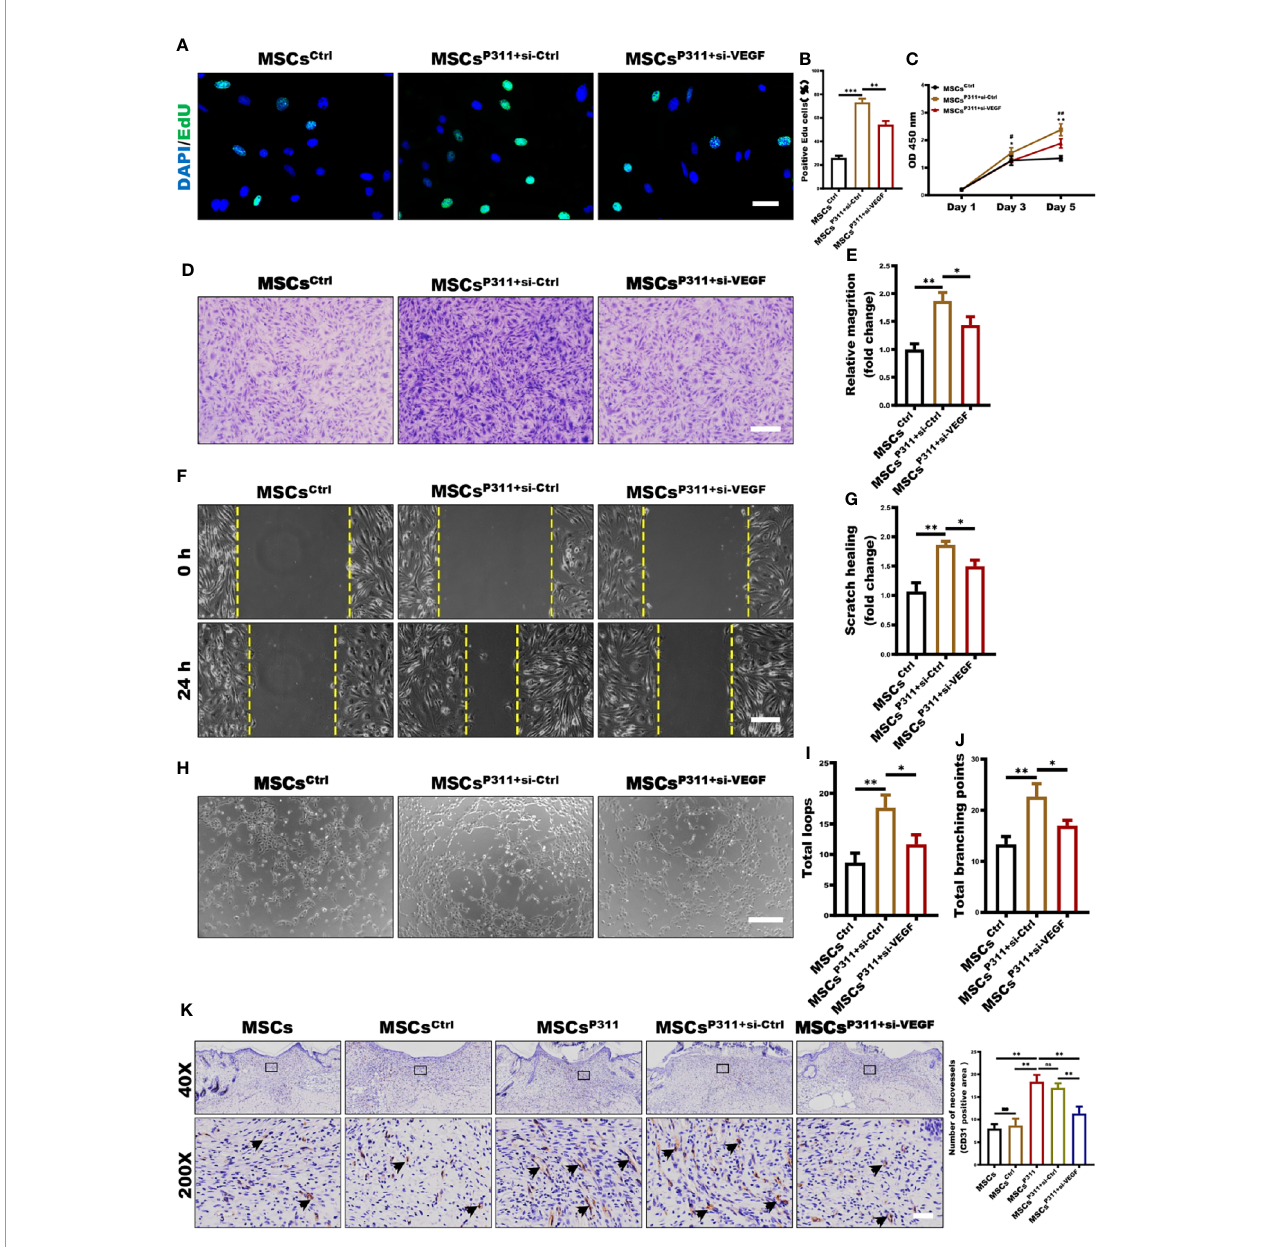
FIGURE 5 | VEGF is essential in P311-mediated angiogenesis of MSCs in vitro and in vivo . The roles of VEGF in P311-mediated promotion of MSCs on ECs proliferation and motility were estimated by using MSCs P311 transfected with VEGF si-RNA (MSCs P311+si-VEGF ) or control vehicle (MSCs P311+si-Ctrl ). (A – E) Using transwell system mentioned above, ECs were co-cultured with MSCs P311+si-VEGF or MSCs P311+si-Ctrl for 24 hours at ratio 4:1. (A, B) The proliferation of ECs was examined at single cell level by EdU assays at 24 hours after co-incubation. Representative confocal images of EdU were shown (left panel), and the number of EdU- positive cells was counted and statistically analysed (right panel). Scale bar: 100 µm. (C) Cell viability for ECs was detected by means of CCK8 assay on day 1, 3 and 5 after co-incubation. (* means MSCs Ctrl vs MSCs P311+si-Ctrl , # means MSCs P311+si-Ctrl vs MSCs P311+si-VEGF ) (D – G) The roles of VEGF in P311-mediated increase in motility of ECs was estimated by detecting the invasion and migration in MSCs P311+si-VEGF or MSCs P311+si-Ctrl co-incubation. (D, E) ECs in upper chamber were co-cultured with MSCs Ctrl , MSCs P311+si-VEGF or MSCs P311+si-Ctrl in lower chamber at ratio 4:1 for 6 hours, and ECs that have migrated through the membrane were stained, counted, and statistically analysed. Scale bar: 200 µm. (F, G) The migration of ECs at 24 hours after co-incubation was detected by scratch assays with transwell co-culture system (0.4-µm pore size). Scale bar: 200 µm. (H – J) The regulation of P311 on pro-angiogenesis functions of MSCs was evaluated by tube-like structure formation assays in vitro . Representative images of tube-like structure formation were shown (left panel) and the number of loops and branch points were counted and statistically analysed (right panel). Scale bar: 200 µm. MSCs Ctrl group: MSCs Ctrl + ECs; MSCs P311+si-Ctrl group: MSCs P311+si-Ctrl + ECs. MSCs P311+si- VEGF group: MSCs P311+si-VEGF + ECs. (K) The representative immunohistochemical staining images of CD31-positive ECs were shown (black arrows, left panel), and the number of vessels was counted and statistically analysed (right panel). Scale bar: 50 µm. Data are representative of at least three independent experiments and represent mean ± SD of indicated number of mice per group. (ns, no statistical signi fi cance; *P < 0.05; **p < 0.01; ***p <